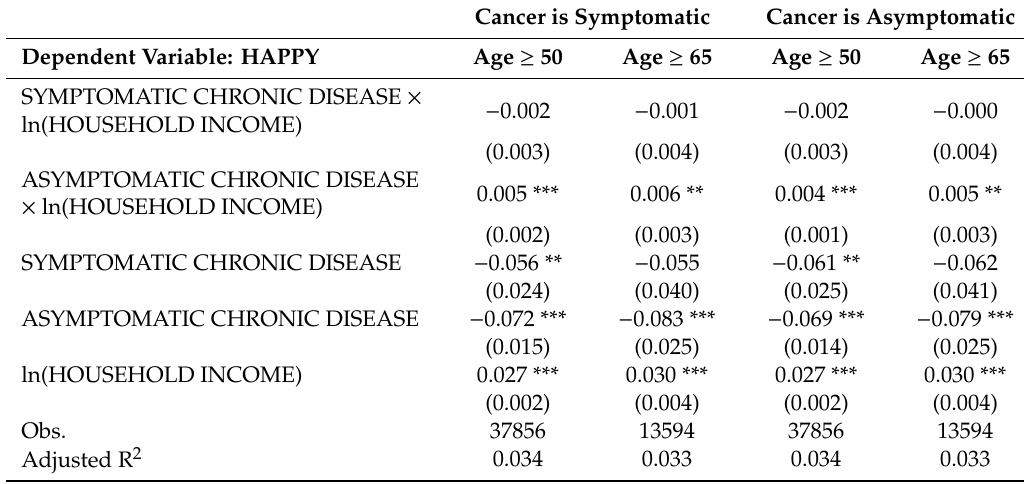
Table 4. By symptomatic and asymptomatic chronic diseases. Cancer is Symptomatic Cancer is